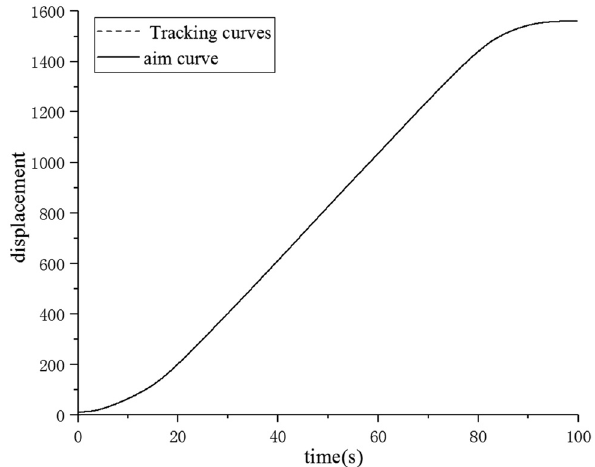
Figure 5: Speed tracking curve and ideal target curve based on